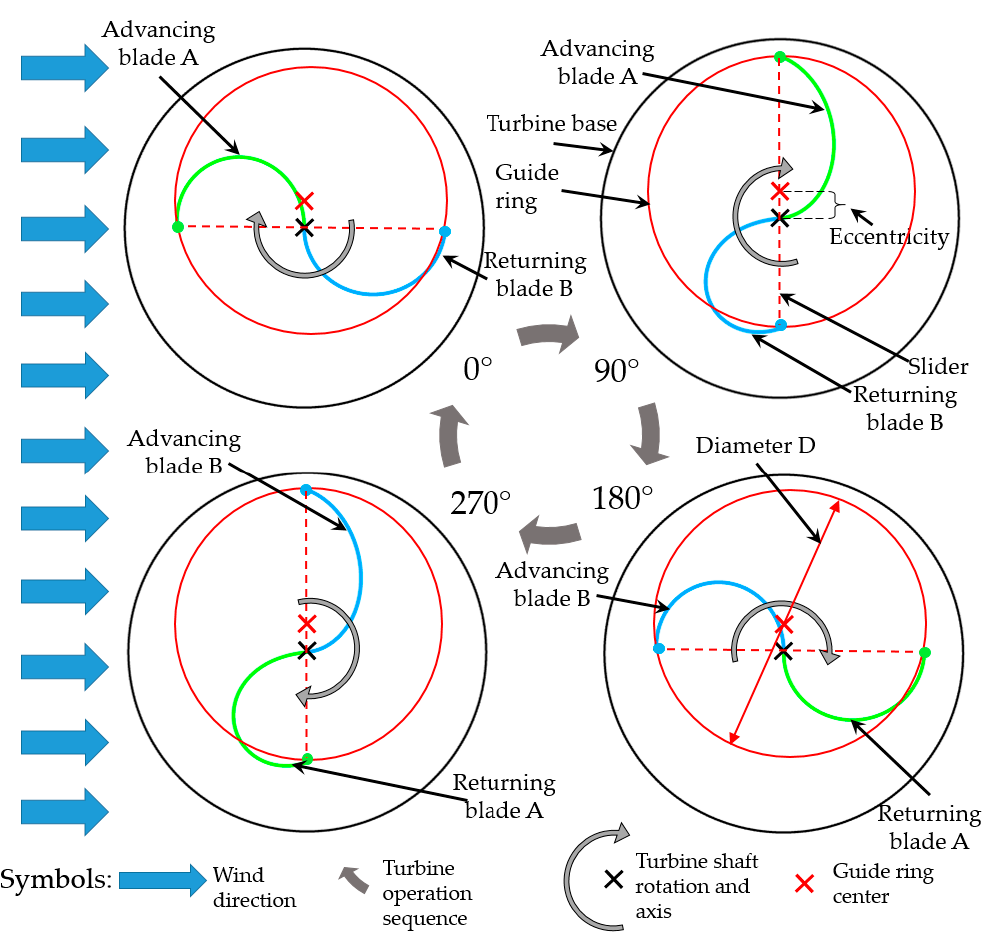
Figure 1. Principle of the turbine operation.